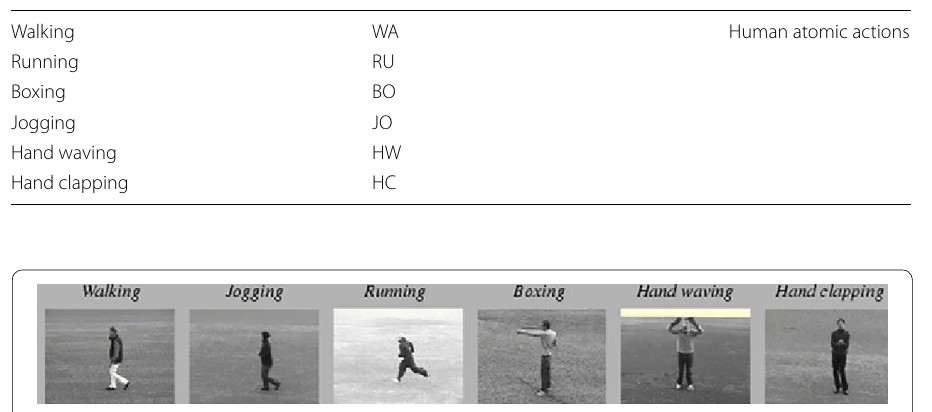
Table 2 Action class categories in KTH dataset with abbreviation Action class